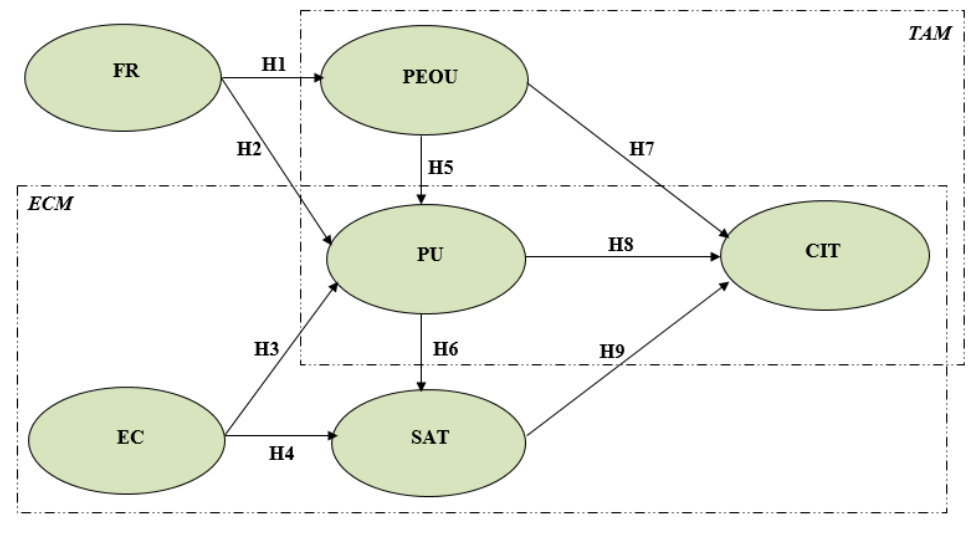
Fig. 1. The study